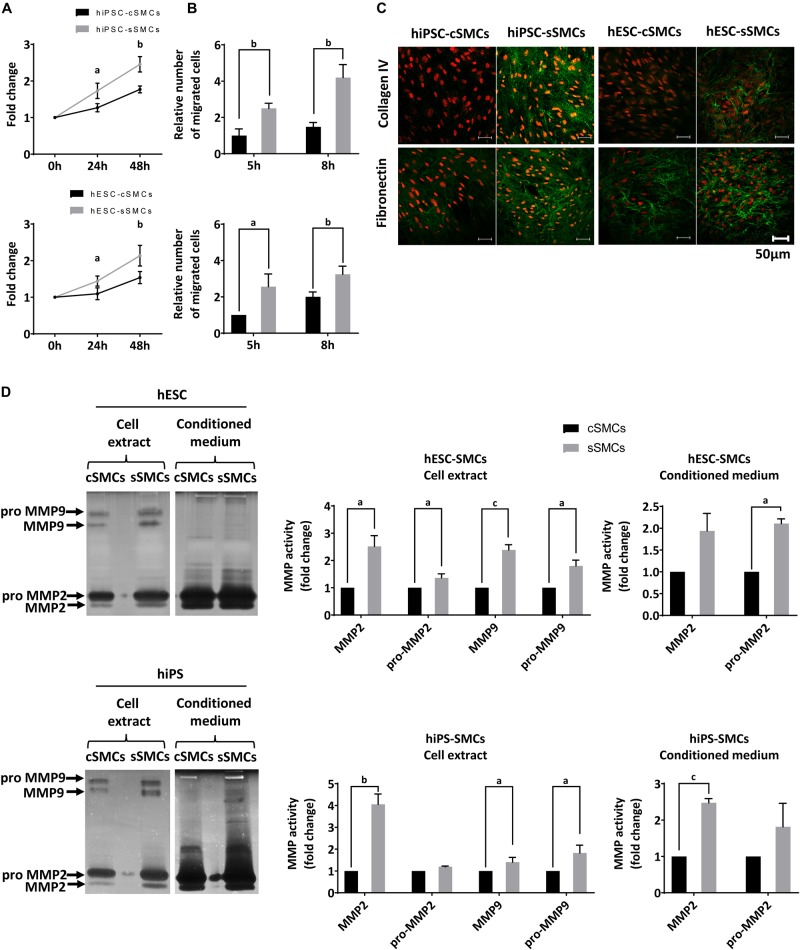
Functional analysis of hPSC-cSMCs and hPSC-sSMCs. (A) Proliferation assay. Numbers of hiPSC-cSMCs, hiPSC-sSMCs (upper graph) and hESC-cSMCs, hESC-sSMCs (lower graph) are expressed as fold change at 24 and 48 h relative to 0 h and presented as means ± SD from three independent experiments. aP < 0.05, bP < 0.01. (B) Migration assay. Relative number of migrated hiPSC-cSMCs, hiPSC-sSMCs (upper chart) and hESC-sSMCs, hESC-cSMCs (lower chart) at 5 and 8 h using the wound healing assay are presented as means ± SD from three independent experiments. aP < 0.05, bP < 0.01. (C) Extracellular matrix deposition. Immunofluorescence analysis performed on hiPSC-cSMCs, hiPSC-sSMCs, hESC-cSMCs, and hESC-sSMCs. Green fluorescence indicates Collagen IV (upper panel) and Fibronectin (lower panel), whereas red fluorescence indicates nuclei (PI stain). Images were taken on Leica TCS SP5 confocal microscope and are representative of three independent experiments. Scale bar, 50 μm. (D) MMP2 and 9 activity. hESC-cSMC, hESC-sSMC (upper image) and hiPSC-cSMCs, hiPSC-sSMCs (lower image) cell extracts and conditioned media were assessed using gelatin zymography. The images are inverted photos of the zymograms and are representative of three independent experiments. Relative MMP activities were evaluated by quantification of band intensities and are presented in the charts. Data are expressed as means ± SD from three independent experiments. aP < 0.05, bP < 0.01, cP < 0.001.